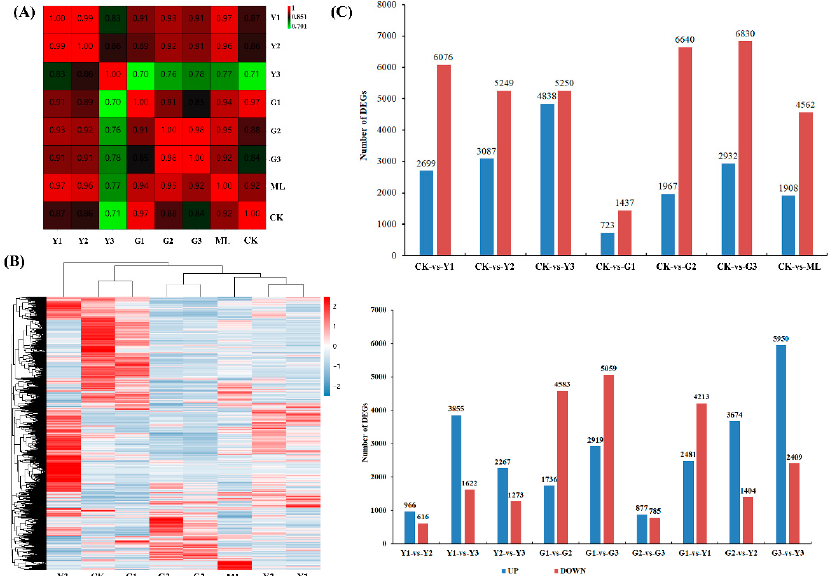
Figure 3. The principal component analysis between the two samples was calculated based on FPKM ( A ); ( B ): heatmap of RNA-seq transcriptome analysis for DEGs. ( C ): number of DEGs between two samples.